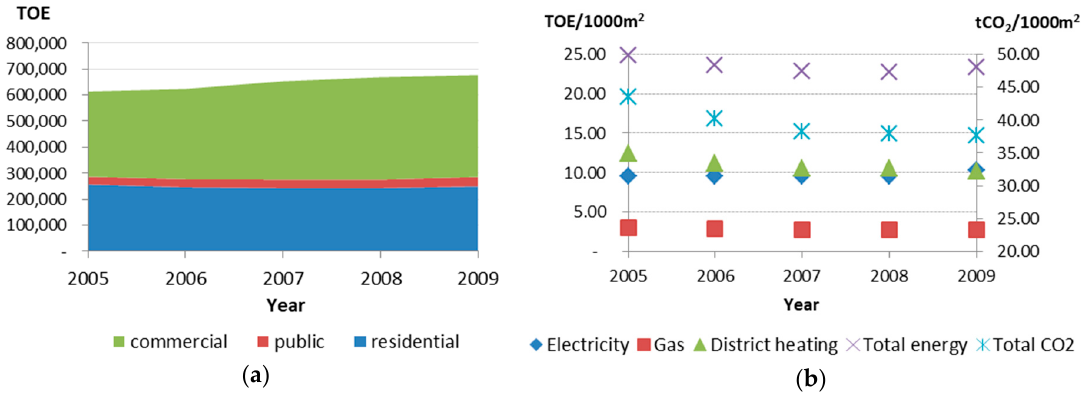
Figure 1. ( a ) Energy consumption in relation to building types; ( b ) energy sources in residential buildings.